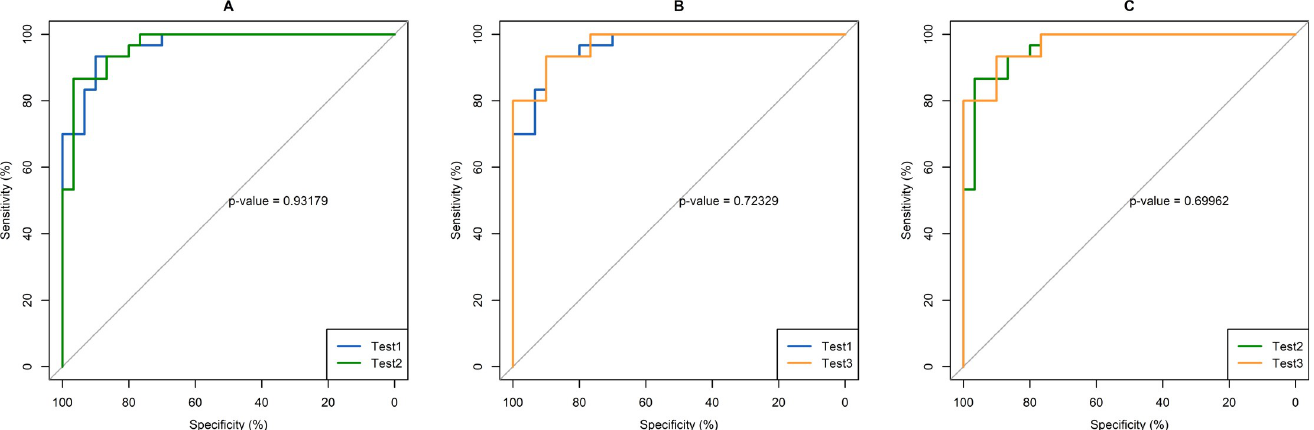
Fig 5. Comparison of ROCs/AUCs of the HpAfr-ELISA assay at three repeated testing. Plots displayed on the figure represent ROC curves and AUCs obtained at repeated tests (test 1, test 2, and test 3) on the training set in intra-observer. No significant difference between the ROC curve was noted (p > 0.05).